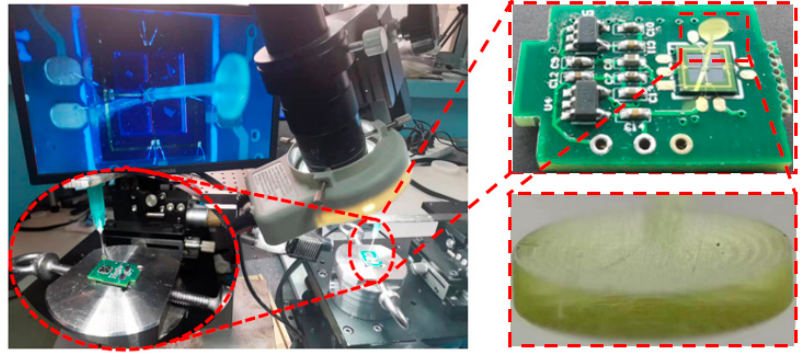
Figure 5. Secondary integration of sensor micro-structure.